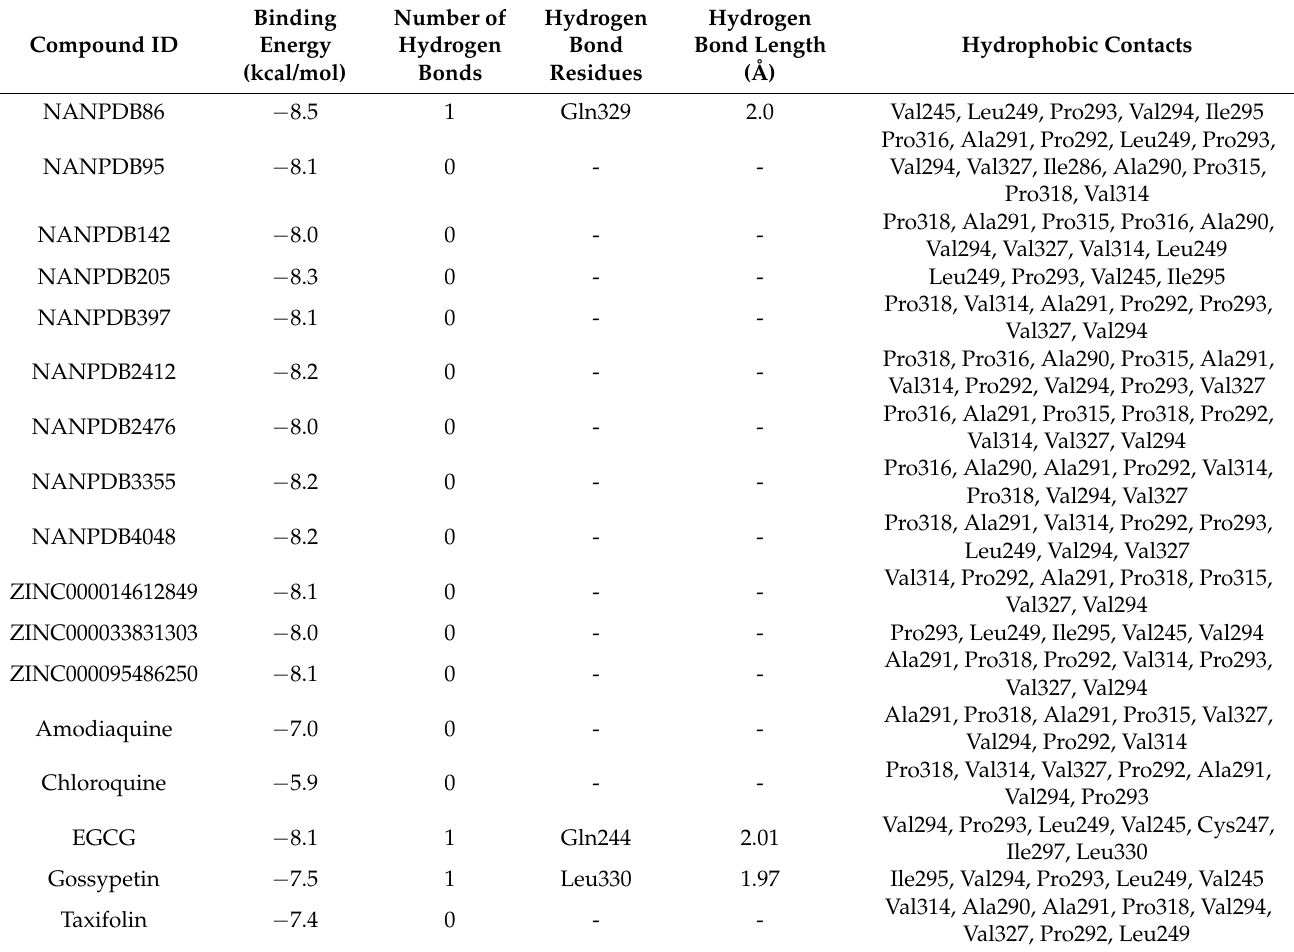
Table 2. The binding energies of selected compounds and known inhibitors as well as their intermolecular bonds with EBOV